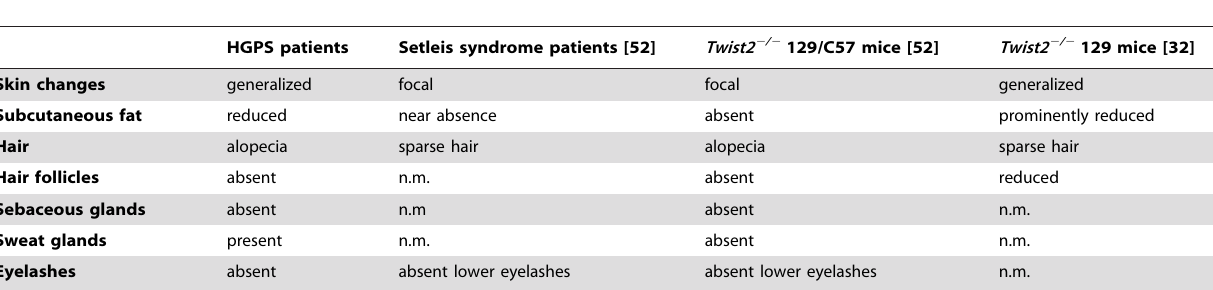
Table 2 . Phenotypic overlap between HGPS, Setleis syndrome patients, and Twist2 2 / 2